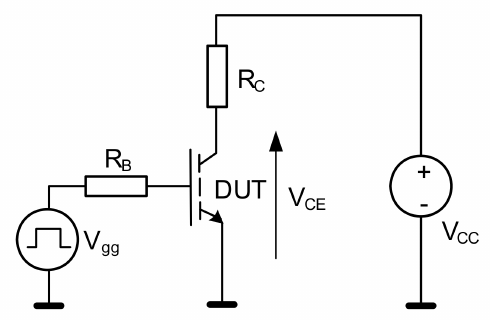
Figure 5. Diagram of the transistor switch including the IGBT.